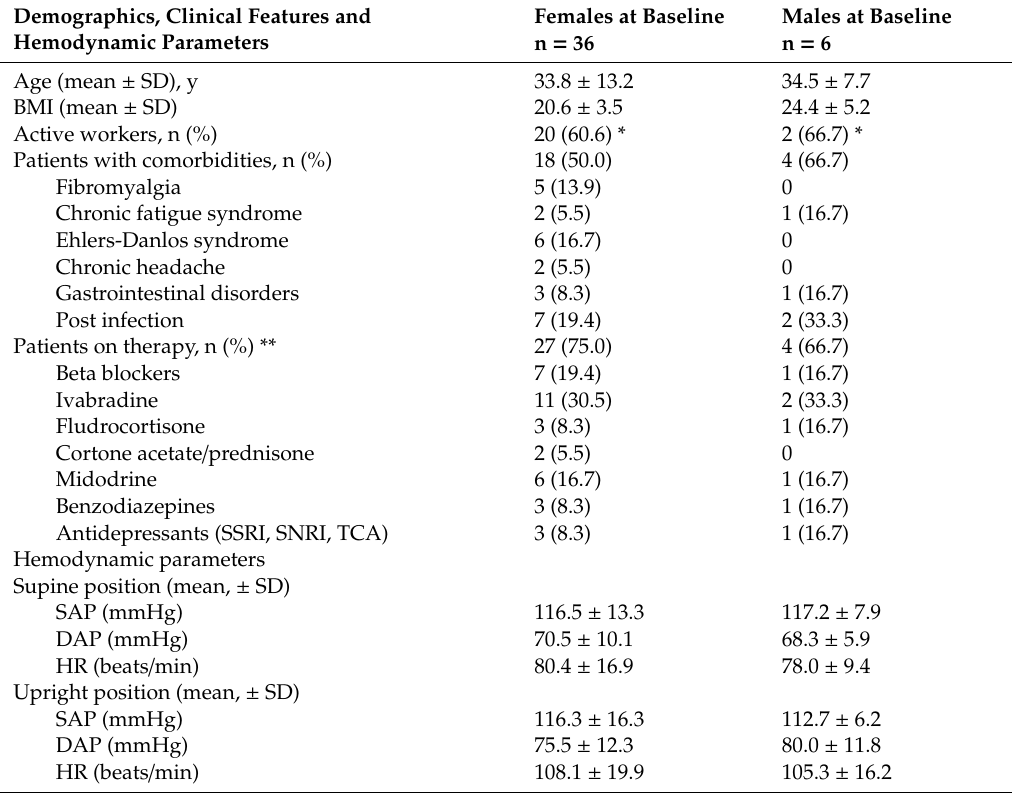
Table 3. Demographic and clinical features of the baseline study population according to gender. Demographics, Clinical Features and